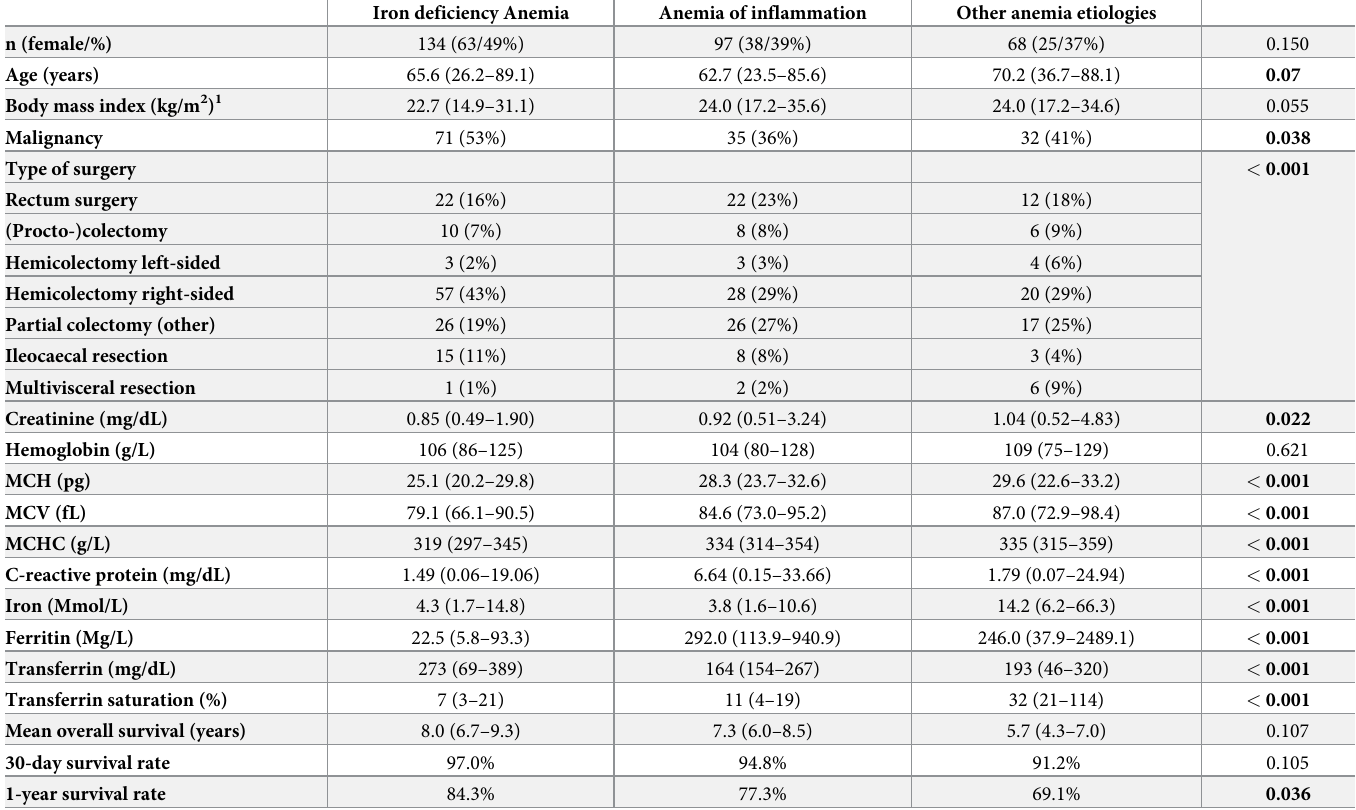
Table 2. Characteristics of patients with anemia and serum iron parameters available grouped by anemia etiology. (Data are presented as numbers and percentages for frequencies and as mean ± standard deviation for normally distributed parameters and as median (25 th —75 th ) percentile for not normally distributed